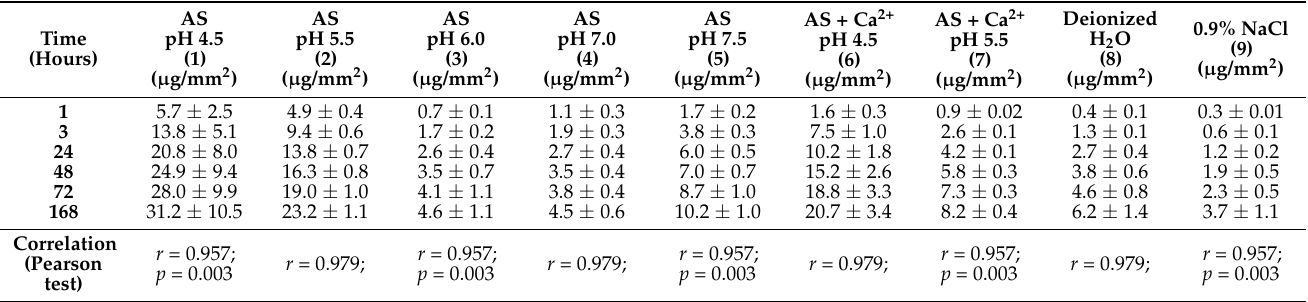
AS: artificial saliva; # : +SD are higher than means because all data for each group were analyzed. Table 4. Cumulated release of fluoride ions ( µ g/mm 2 ) from compomer Freedom (F) into nine environments differing in composition of the solution and pH. Six samples were prepared for each solution. Descriptive data were presented as mean ± standard deviation ( ± SD). Data for correlation analysis were logarithmically